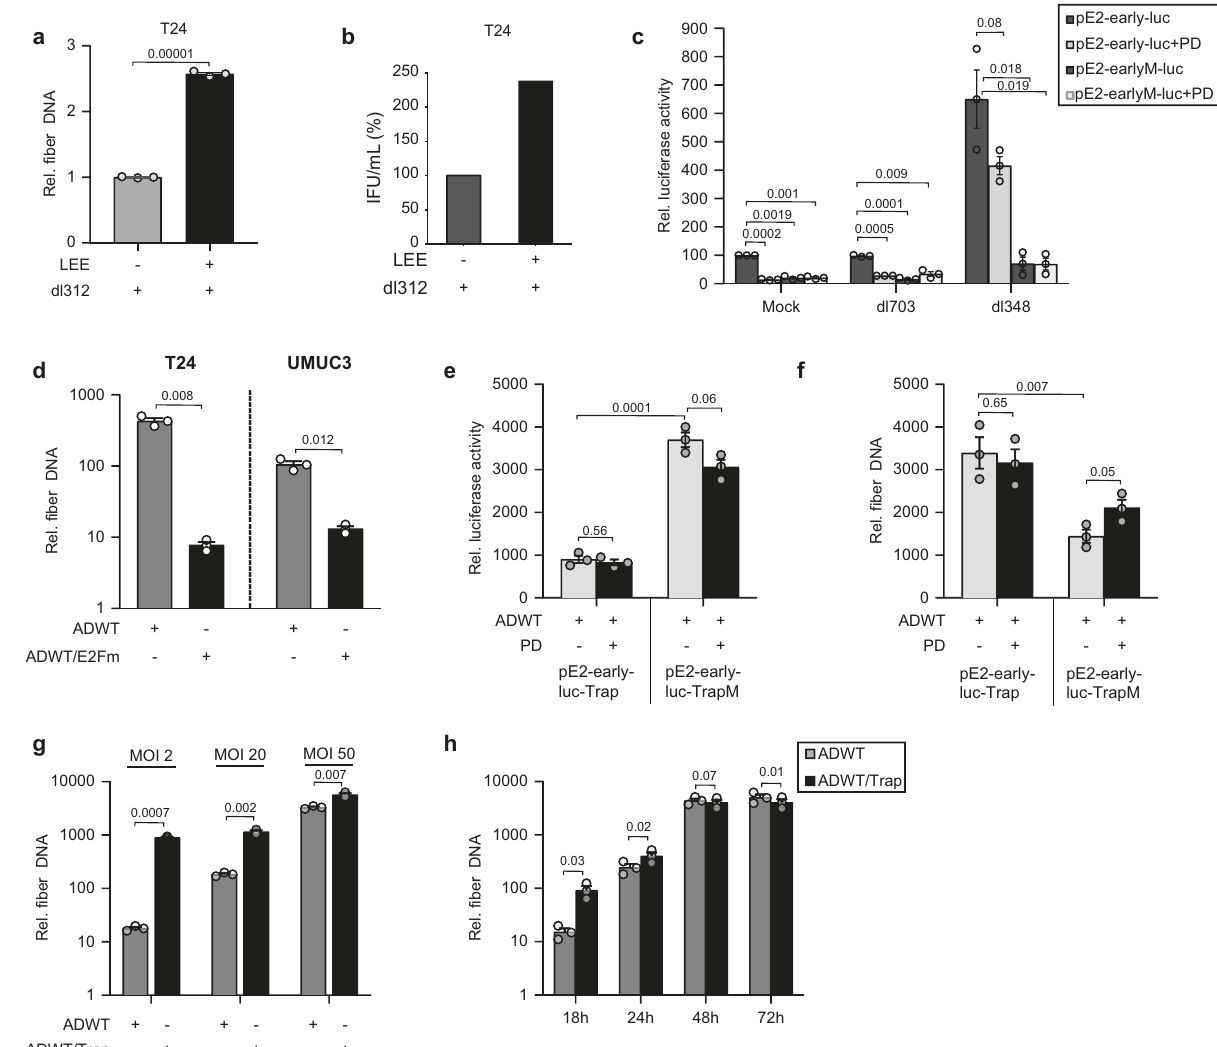
Fig. 6 | E2F binding sites in the adenoviral genome in fl uence viral life cycle. a , b T24 cells were pre-treated with Ribociclib and infected with the E1A-deleted virus dl312 (MOI 50). a Viral genome replication was assessed at 48hpi. n =3. b Quanti fi cationofviralparticleswasperformedbyahexontitertestandpresented as infectious units per milliliter (IFU/ml) ( n =3, mean±SE). c E2-early promoter activity was examined by transfecting T24 cells with plasmidspE2-early-luc or pE2- earlyM-luc. Cells were pre-treated with Palbociclib (0.5 µ M) and infected with adenoviruses dl703or dl348(MOI100).Luciferase activity wasmeasured at42hpi. Results are presented as relative luciferase activity in the percentage of control, ( n =3,mean±SE). d ViralgenomereplicationuponE2F-bindingsitemutationinE2- earlypromoterwas assessedinT24and UMUC-3cellsthatare infected with ADWT or ADWT/E2Fm (MOI 10) at 24hpi. e , f The effect of E2F-binding on E2-early pro- moter activity was assessed in T24 cells that were transfected with a plasmid